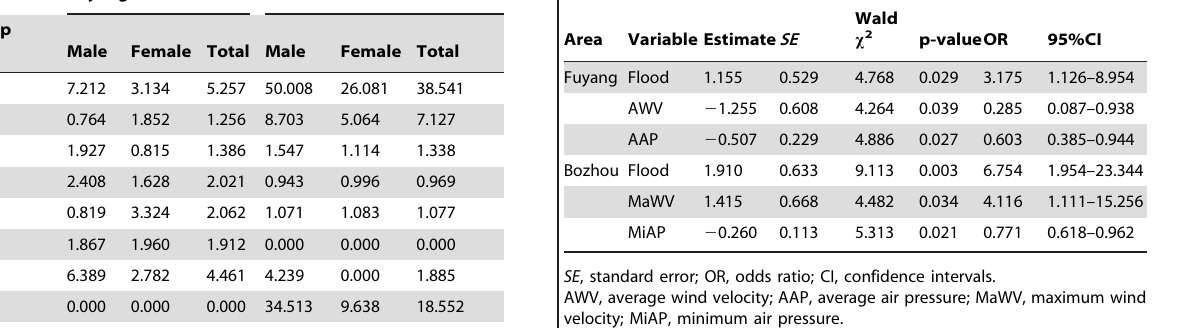
Table 4. Parameters of the variables which were significantly included in the multifactorial conditional logistic models in the two areas.